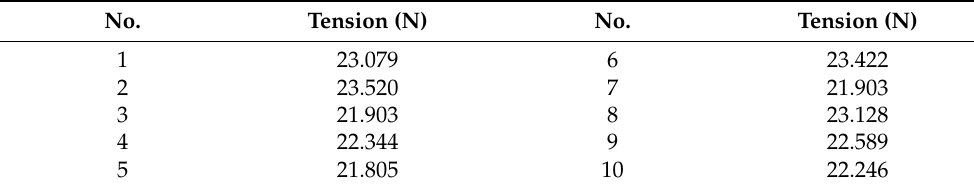
Table 5. Tensions to separate mask from the contact surface.